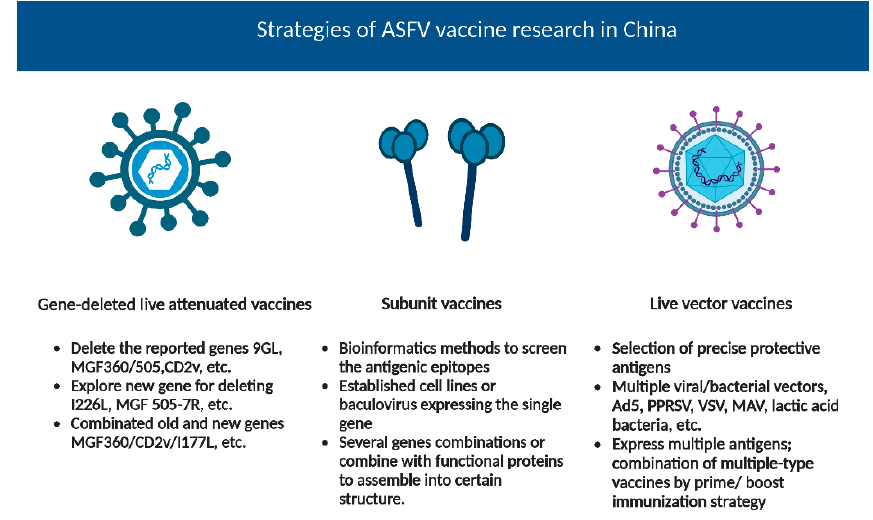
Figure 2. Created using BioRender.com.